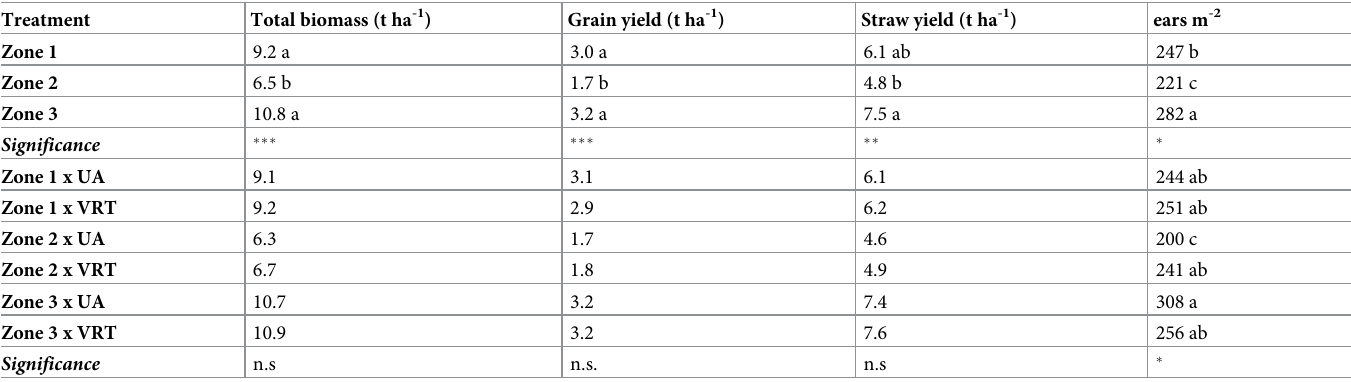
Table 3. Biomass and yield in the different experimental conditions of durum wheat.